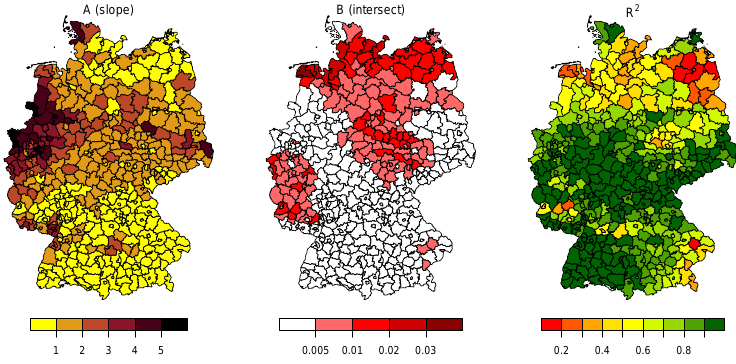
Fig. 4. Regression coefficients for scaling the local loss potentials calculated from ERA-Interim gust wind speeds towards the insurance loss records (VGV). Left: slope of the linear regression (coefficient A ). Middle: axis intercept (coefficient B ). Right: coefficient of determination ( R 2 )